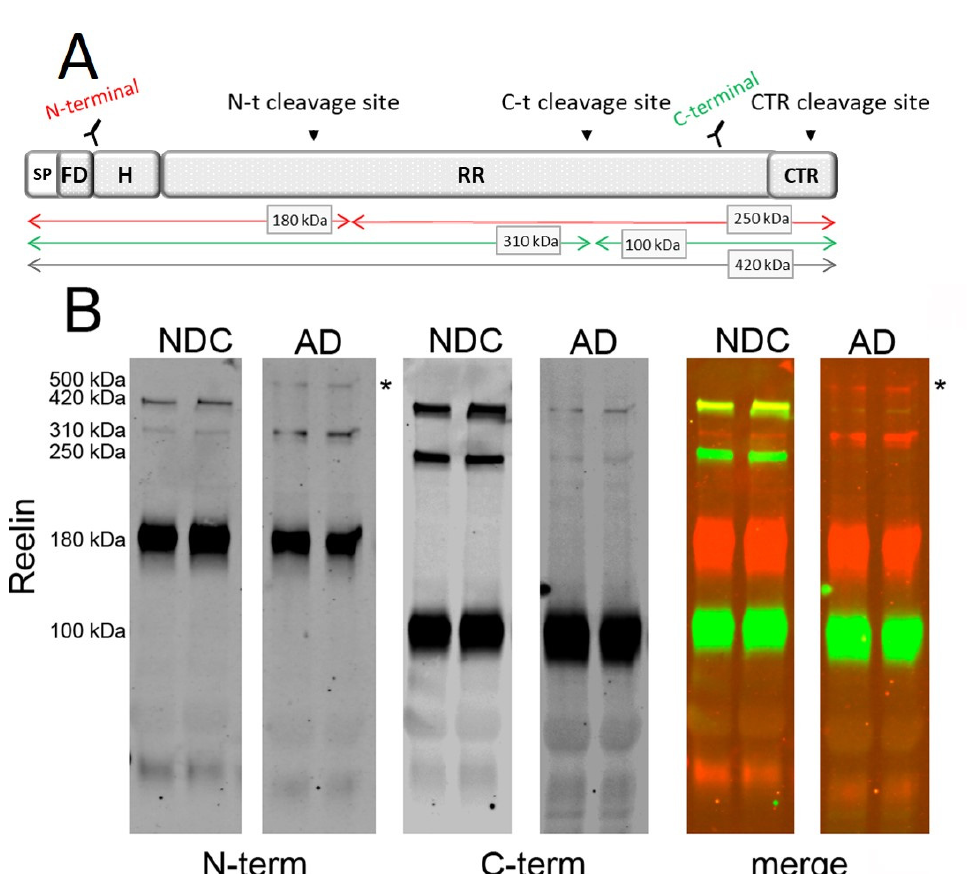
Figure 1. Reelin species present in human CSF. ( A ) Schematic representation of full-length reelin, the proteolytic cleavage site, and the epitope recognized by the antibodies used in the study. The reelin N-terminal region begins with a signal peptide (SP), an F-spondin-like domain (FD), and a hinge segment (H). This is followed by eight similar repeats (RR) separated by an EGF-like domain. The protein ends with a highly basic C-terminal region (CTR). Reelin cleavage at the N- and C-terminal regions leads to the formation of either 310 and 180 kDa N-terminal fragments of 100 kDa and 250 kDa C-terminal fragments, respectively. ( B ) The same human CSF samples from non-disease control (NDC) and AD subjects were simultaneously probed by Western blotting using multiplex fluorescence resolved with reelin N- and C-terminal antibodies. Representative blots of the N-terminal reelin bands (red) and C-terminal reelin bands (green) are shown, as well as simultaneous fluorescence (merge) demonstrating co-localization (yellow). * indicates ~500 kDa reelin immunoreactive band for N-terminal antibody present only in AD samples. The uncropped blot is included as Supplemental Figure S1.